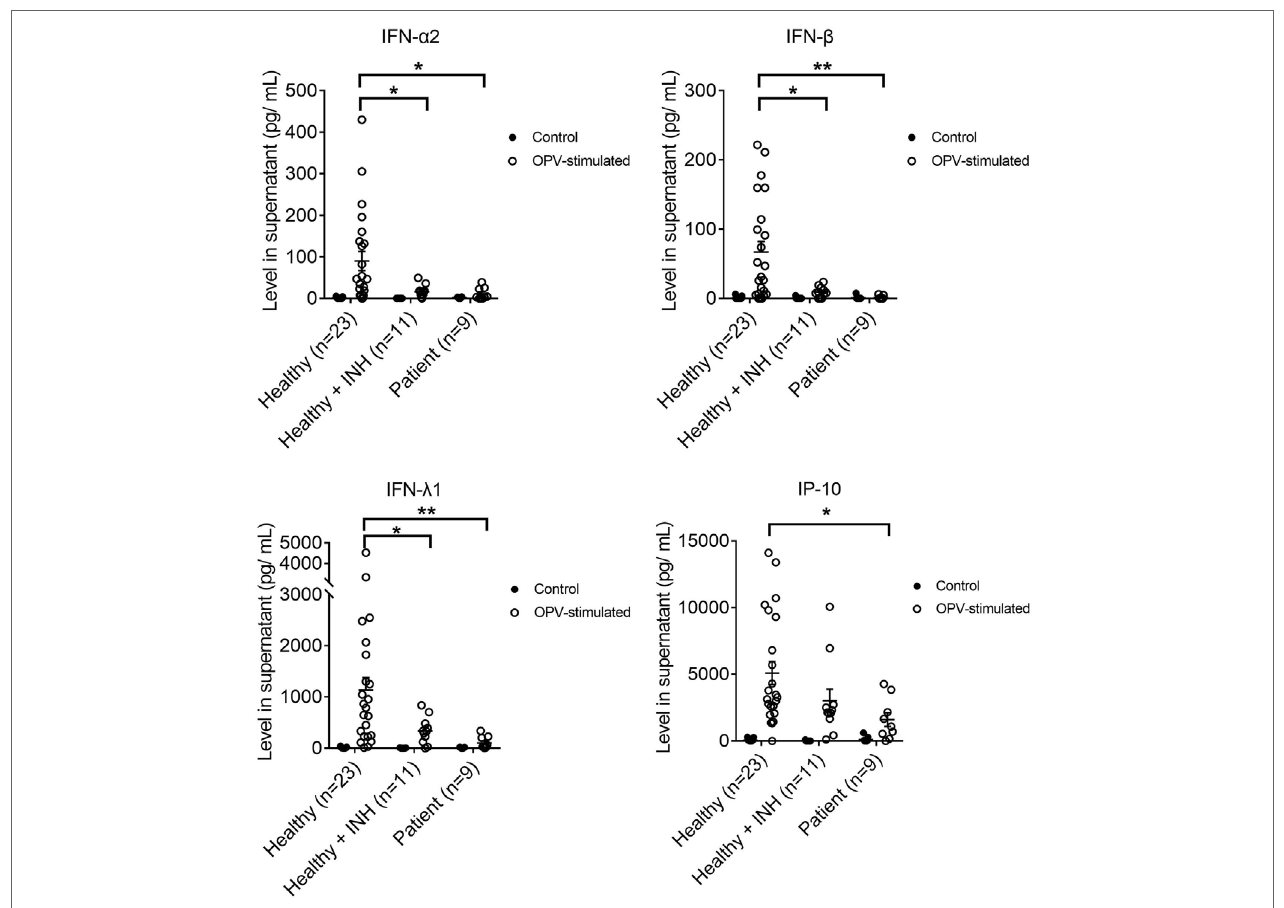
FigUre 3 | IFN- α 2, IFN- β , IFN- λ 1, and interferon gamma-induced protein 10 productions in MoDCs from healthy controls ( n = 23), Bruton’s tyrosine kinase (BTK)-inhibited MoDCs from healthy controls ( n = 11), and MoDCs from X-linked agammaglobulinemia patients ( n = 9) upon OPV stimulation. MoDCs were stimulated with OPV at multiplicity of infection of 1 for 24 h. Open symbols represent MoDCs stimulated with OPV; filled symbols represent MoDCs that were mock-stimulated with RPMI. Healthy + INH, BTK-inhibited MoDCs from healthy controls. Data represented as mean ± SEM. * p < 0.05 and ** p <